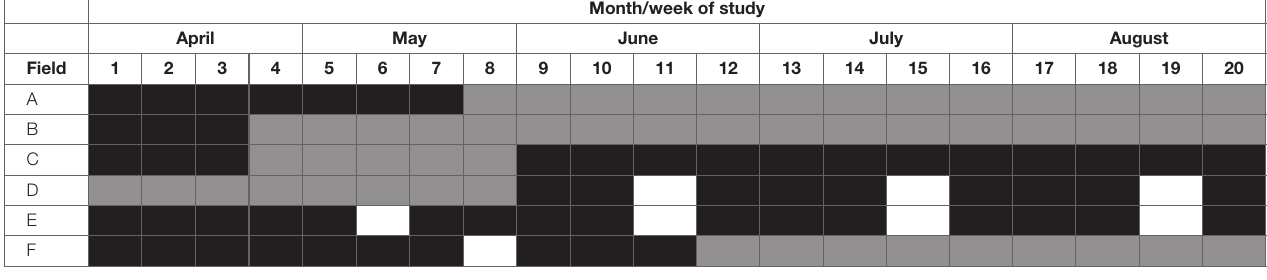
TABLE 2 | Illustration showing periods of pasture regrowth (black), grazing (gray), and silage harvest (white) for each field (A to F) during the 20 weeks of the study.